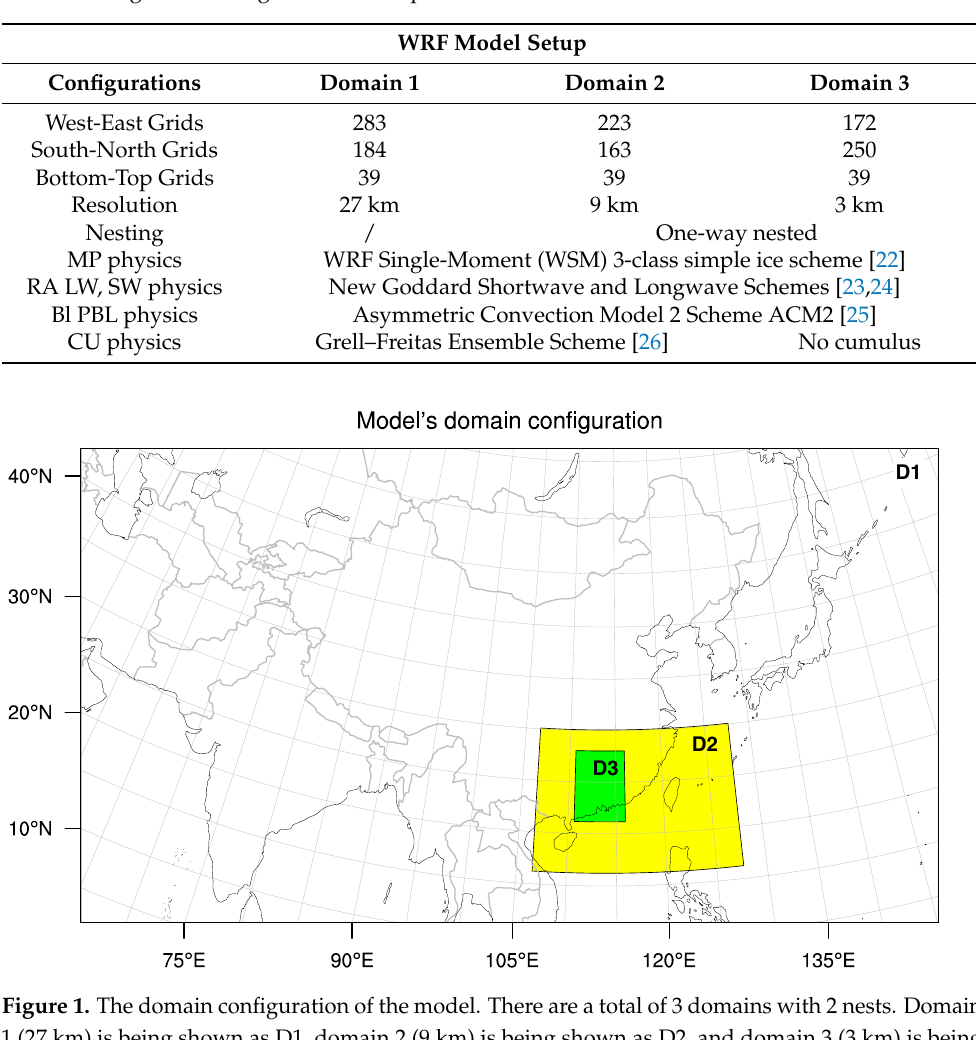
Table 1. The general configuration of the parent and the child domains of the WRF model.